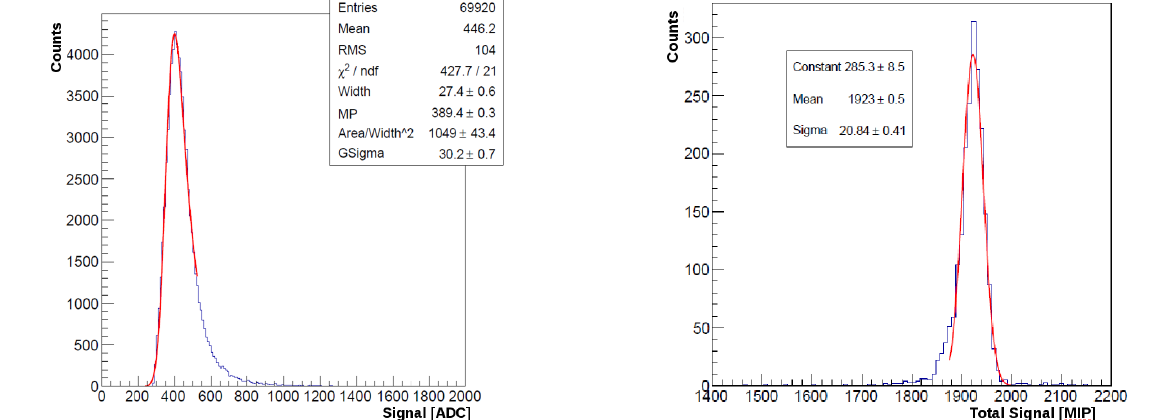
Figure 6. Left Panel : Signal induced by minimum interacting particles (150 GeV muons) in a cube, used to equalize the crystal responses, fitted to the expected Gaussian distribution (red curve); Right Panel : Measured distribution of total energy (expressed in MIP units) released with a 50 GeV electrons beam, fitted to the expected Gaussian distribution (red